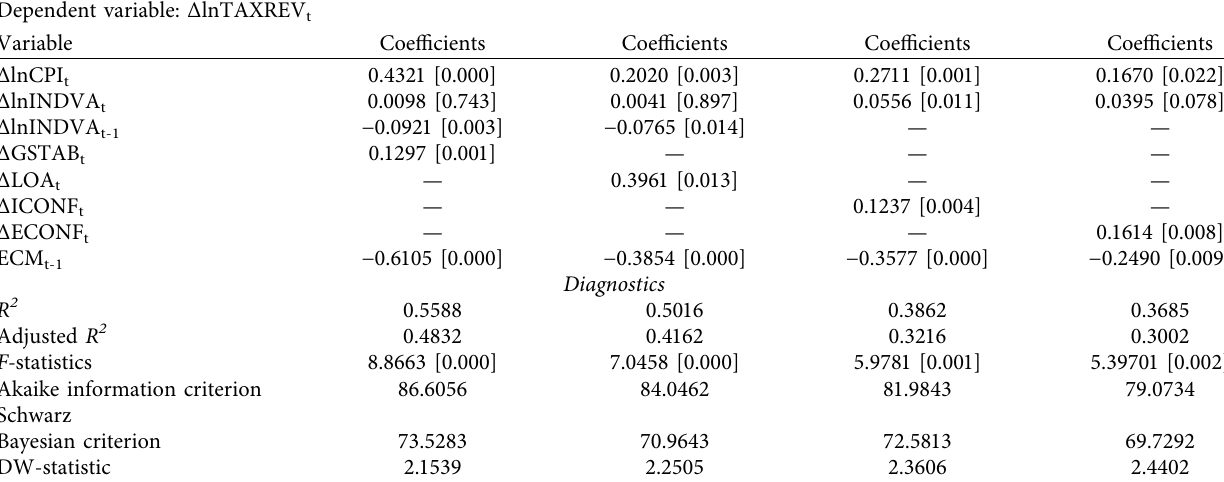
Table 7: Short-run coefficients for the selected ARDL